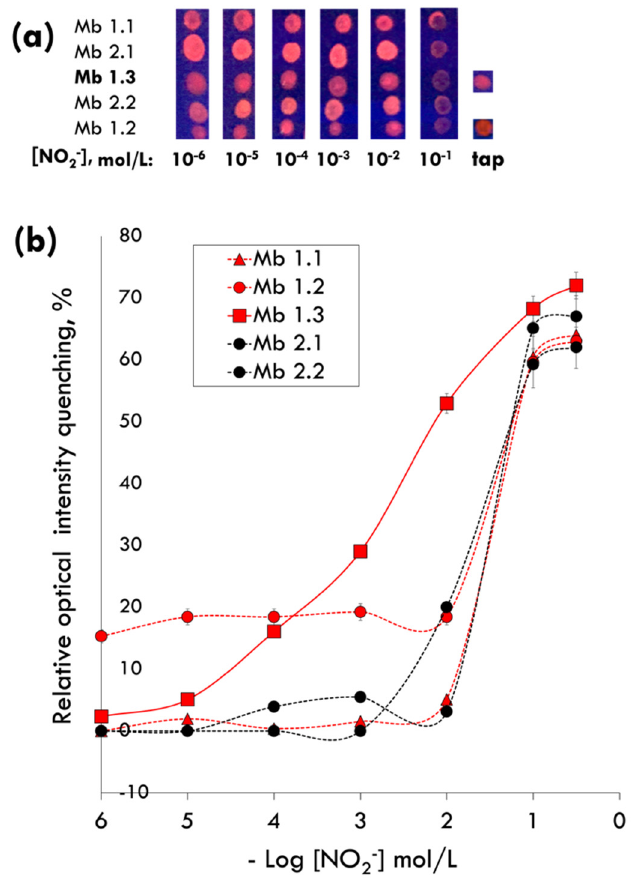
Figure 5. ( a ) The photogram of PFCorr - and PCorr -based optodes in solutions of NO 2 − ions on 0.01 M